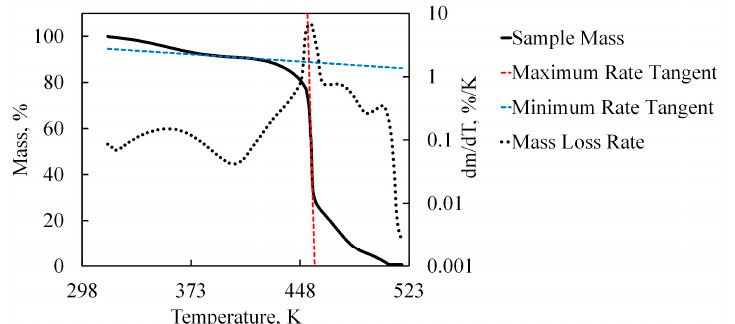
Figure 5. A dynamic TGA thermogram of a 10 K/min constant heating ramp applied to 90% aqueous HAN with tangent lines at maximum and minimum mass loss rate for the HAN decomposition event showing the location of the decomposition onset temperature at 452.9 K.